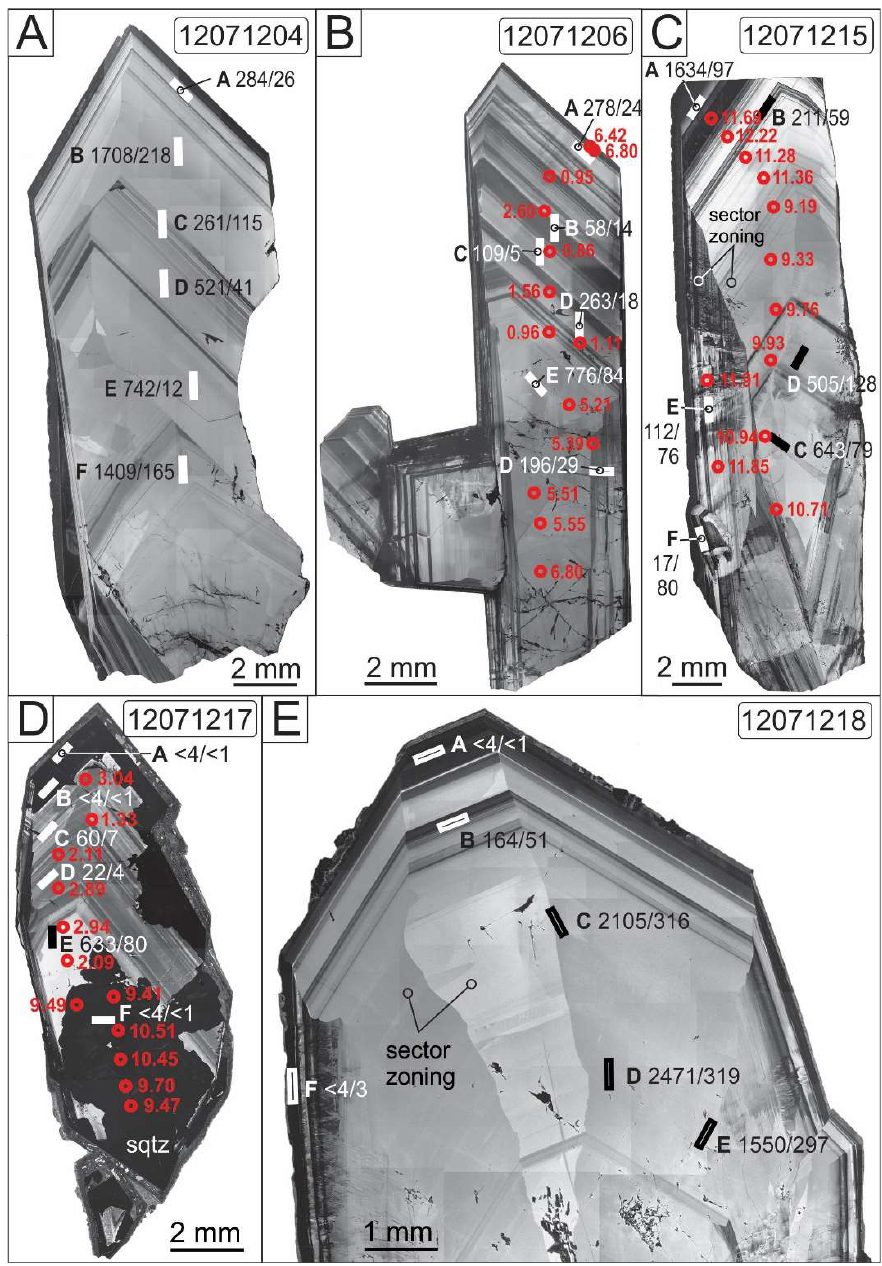
Figure 8. SEM-CL images of quartz crystals of the Berglia-Glassberget mineralization. The white and black bars indicate the location of ICP-MS ablation rasters with the corresponding Al/Li concentrations. The red circles mark the location of SIMS measurements with corresponding δ 18 O VSMOW values in ‰ (in red). ( A ) Sample 12071204, ( B ) Sample 12071206, ( C ) Sample 12071215, ( D ) Sample 12071217, ( E ) Sample 12071218. Sqtz—secondary quartz.